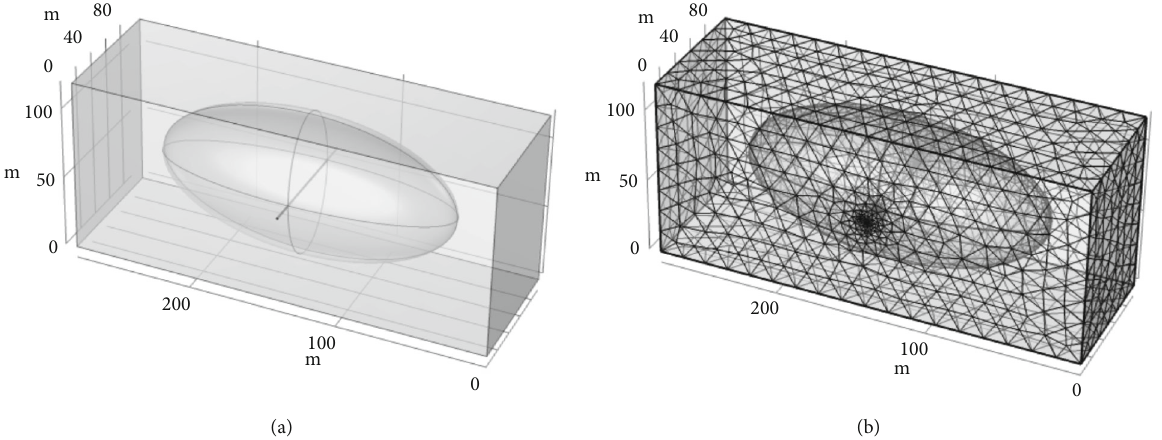
Figure 5: Illustration of the multiphysics, multidomain model: (a) geometric model and (b) meshing